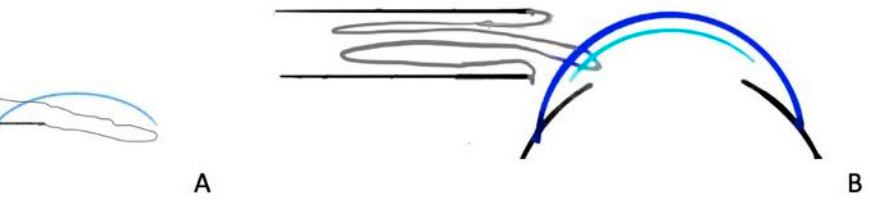
Figure 4. Unicameral Dsaek delivery with suturing of the posterior lamellar graft. ( A ) A double ended 10/0 straight prolene needle (STC-6) is passed through the donor ( B ) both ends of the suture are pre placed through the cornea opposite to the main incision; then, only after the delivery and centration of the graft, the suture is tightened.